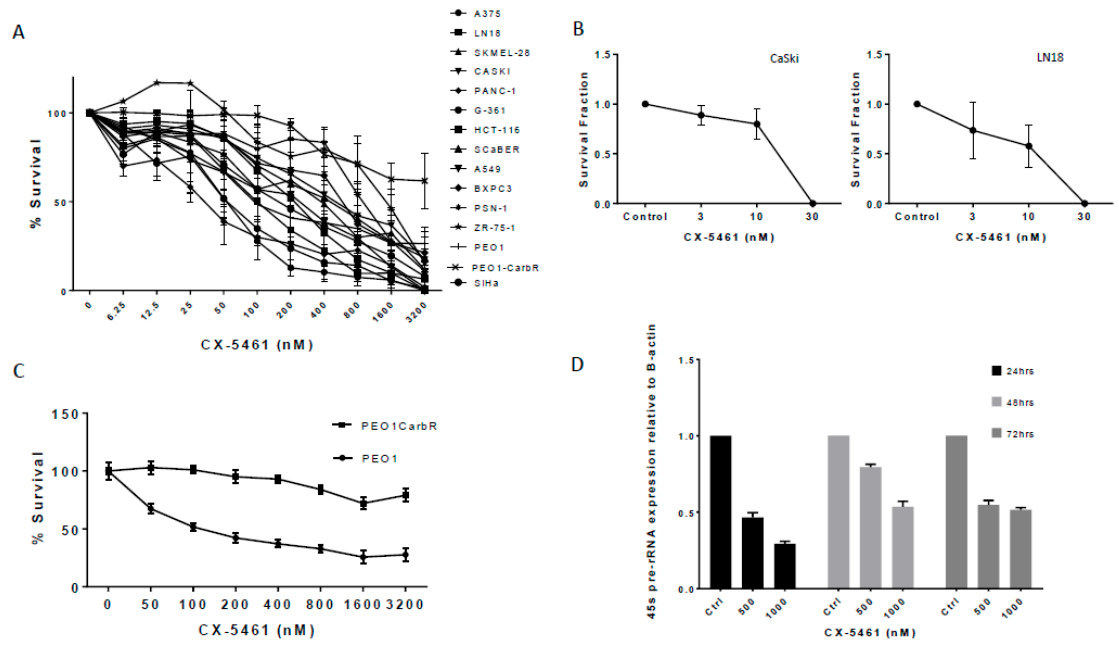
Figure 1. CX-5461 is a potent inhibitor of RNA Polymerase I in solid cancer cell lines. A panel of fifteen solid cancer cells lines was exposed to CX-5461 over 96 h with cell viability assessment using the MTS assay ( A ). Each cell line was set up in triplicate on the day of experiments and repeated on three separate occasions. ( B ) CX-5461 as an anti-proliferative agent. Graphs showing survival fraction values of CaSki (top) and LN18 (bottom) following exposure to CX-5461. Doses of 30 nM were sufficient to prevent the formation of colonies in both cell lines. ( C ) Cell viability data obtained using the MTS assay in PEO1 (BRCA mutant) and PEO1 carboplatin resistant (BRCA wild-type) cell lines showing the difference in sensitivity towards CX-5461. ( D ) qPCR evaluation of 45s pre rRNA transcription of CaSki cell line following exposure to CX-5461 over 72 h. cT values were normalised against the housekeeping gene B-actin. Transcription of 45s pre rRNA was found to significantly decrease ( p -value < 0.0001) in a dose-dependent manner. Table 1. IC 50 values of solid cancer cell lines exposed to CX-5461 over 96 h alongside their respective p53 status. Each cell line was exposed to CX-5461 in triplicates on the day of experiments and also on three separate occasions with different passage numbers for each separate repeat.